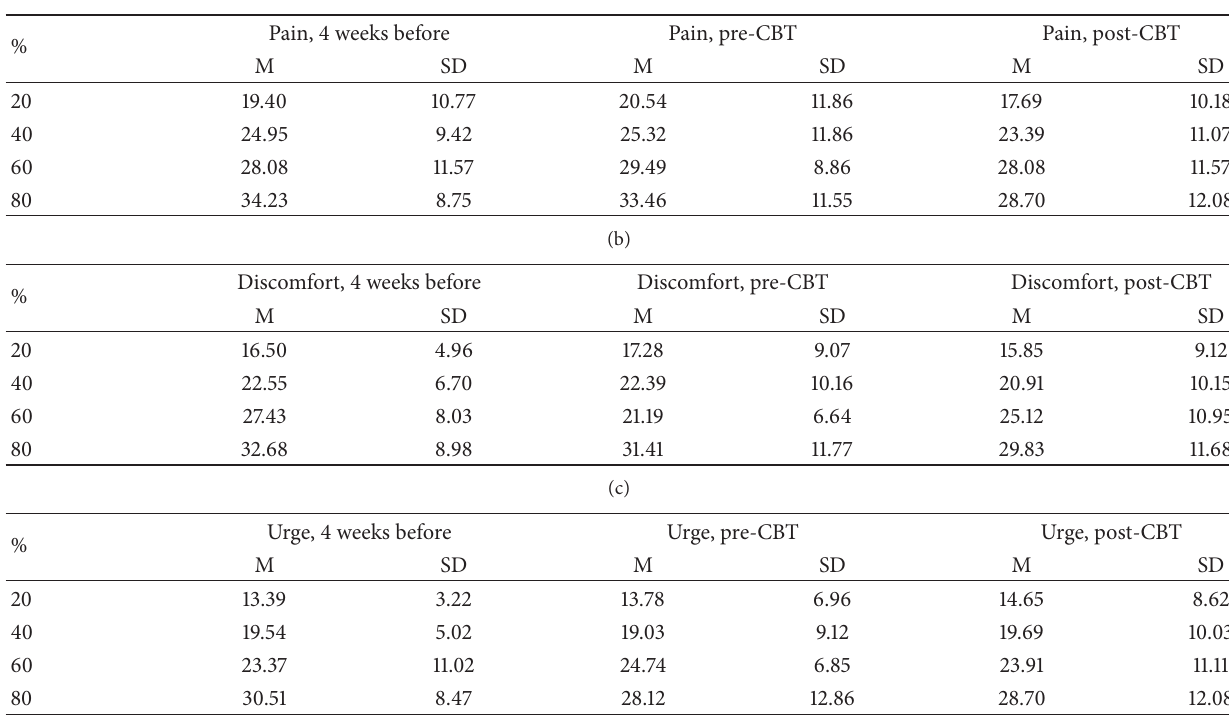
Table 2: Descriptive data for dependent variables.